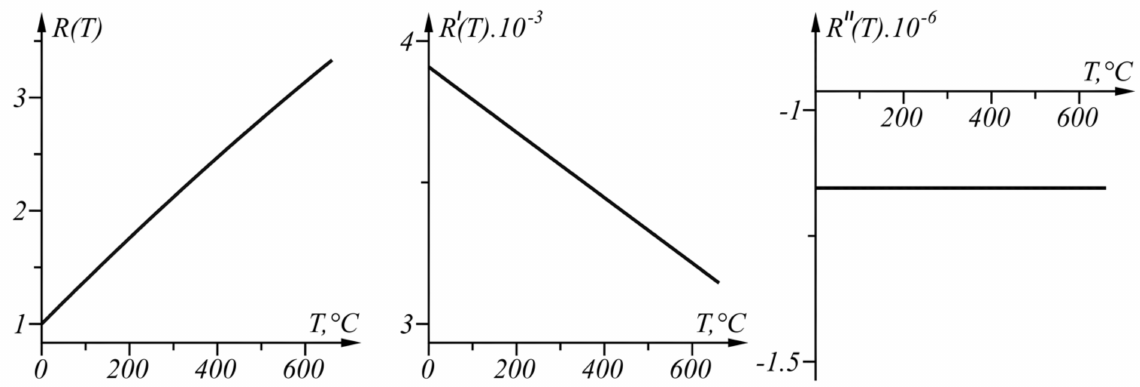
Figure 6. Graphs of the functions R ( T ) , R (cid:48) ( T ) , and R (cid:48)(cid:48) ( T ) in the range T ∈ [ 0, 661 ] ◦